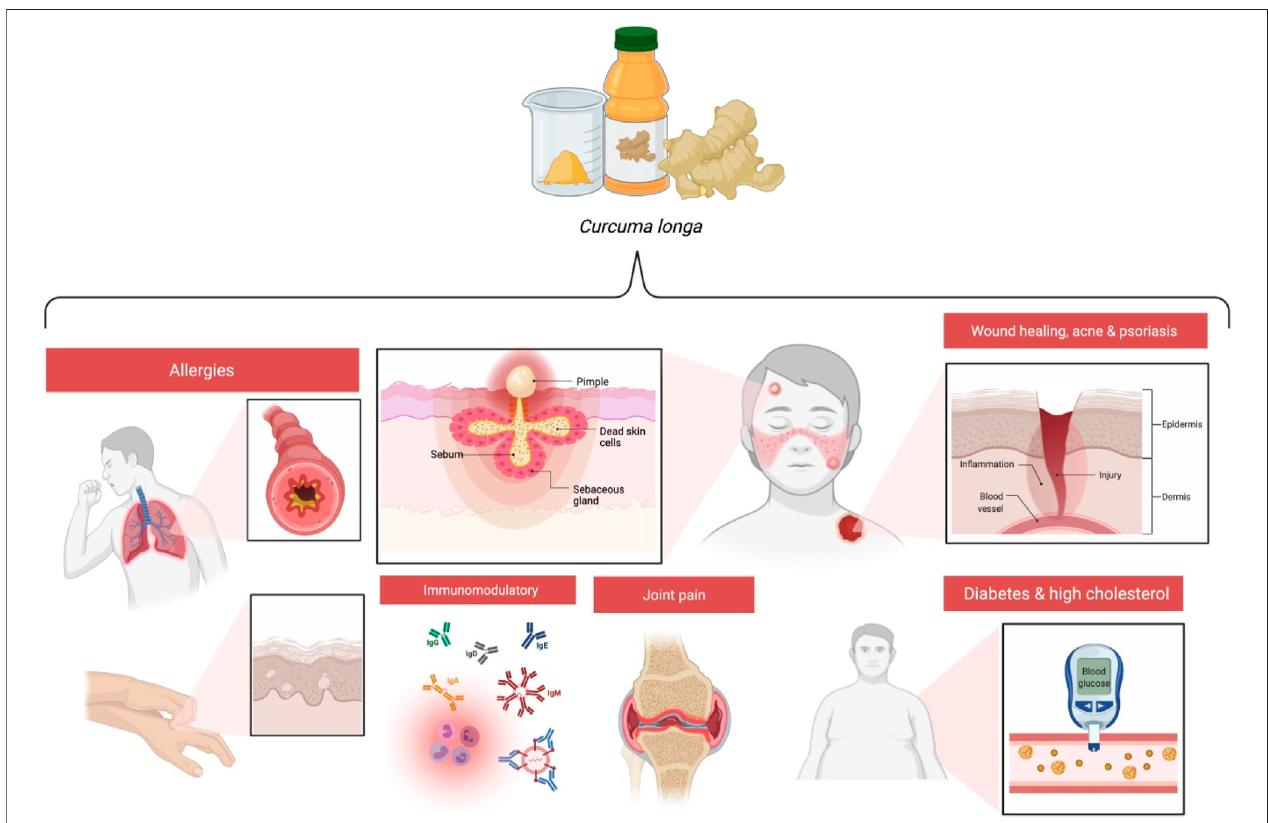
FIGURE 3 | Bene fi ts of curcumin in various